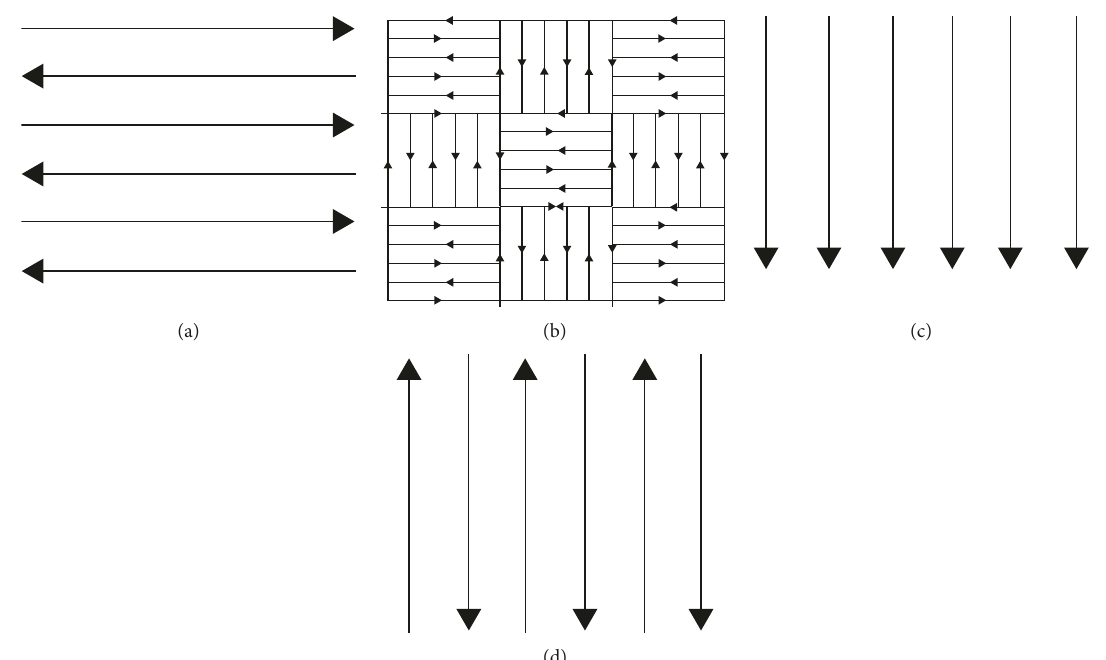
Figure 3: Scanning strategies: (a) antiparallel horizontal, (b) chess field, (c) unidirectional, and (d) bidirectional.